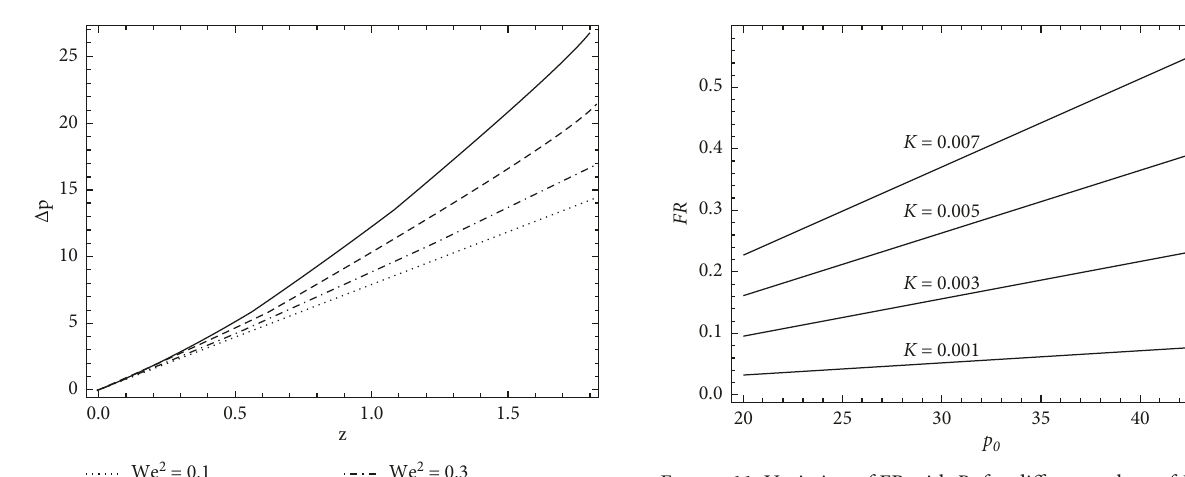
Figure 11: Variation of FR with P 0 for different values of K , where We 2 � 0.001.